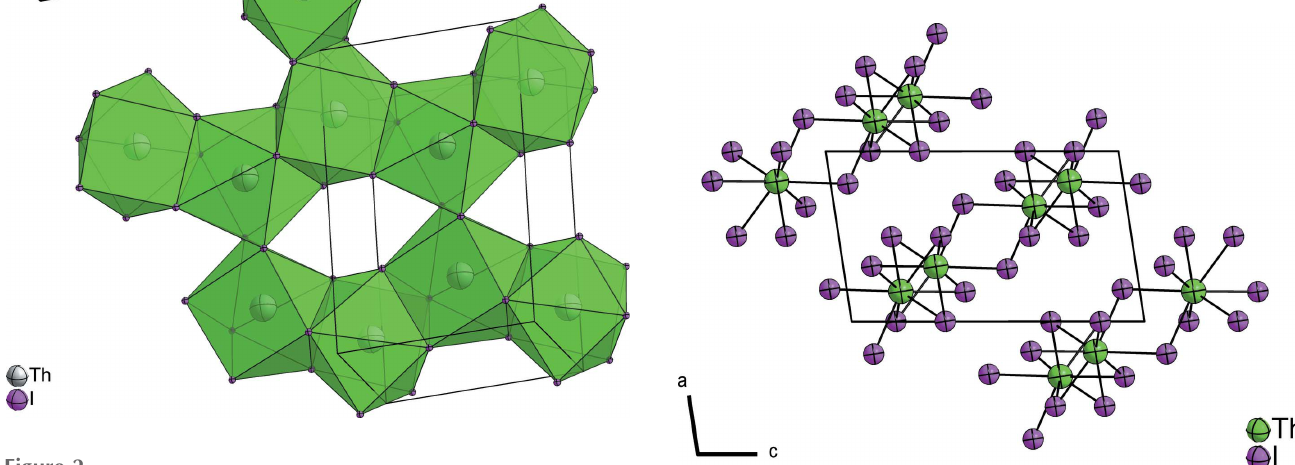
Figure 2 A section of the 2 1 [ThI 6/2 I 2/2 ] layer within the crystal structure of ThI 4 , showing the connection of the coordination polyhedra via faces and edges. Coordination polyhedra are shown transparent in green, atomic radii are arbitrary.